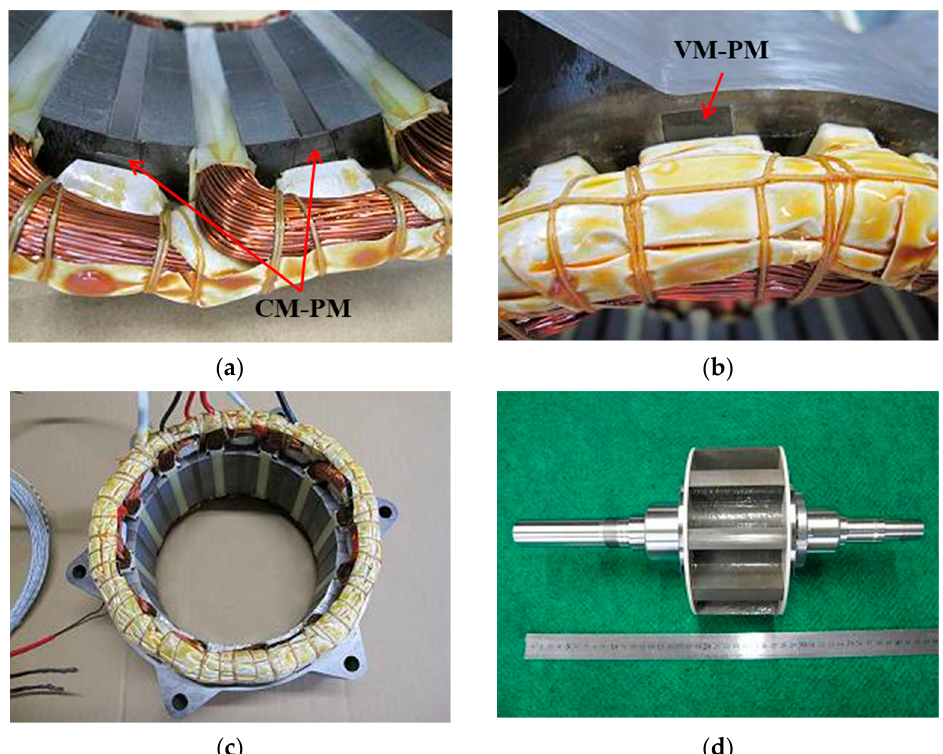
Figure 8. Photographs of fabricated new HEFSM. ( a ) enlarged view of stator (CM-PM); ( b ) enlarged view of stator (VM-PM); ( c ) whole stator assembly; ( d ) whole rotor assembly. ©2020 IEEE. Reprinted with permission, from K. Otsuka, T. Okada, T. Mifune, H. Matsumori, T. Kosaka and N. Matsui, Table 6. Specifications of armature windings and FECs in the fabricated conventional and new HEFSMs. Items Conventional Armature